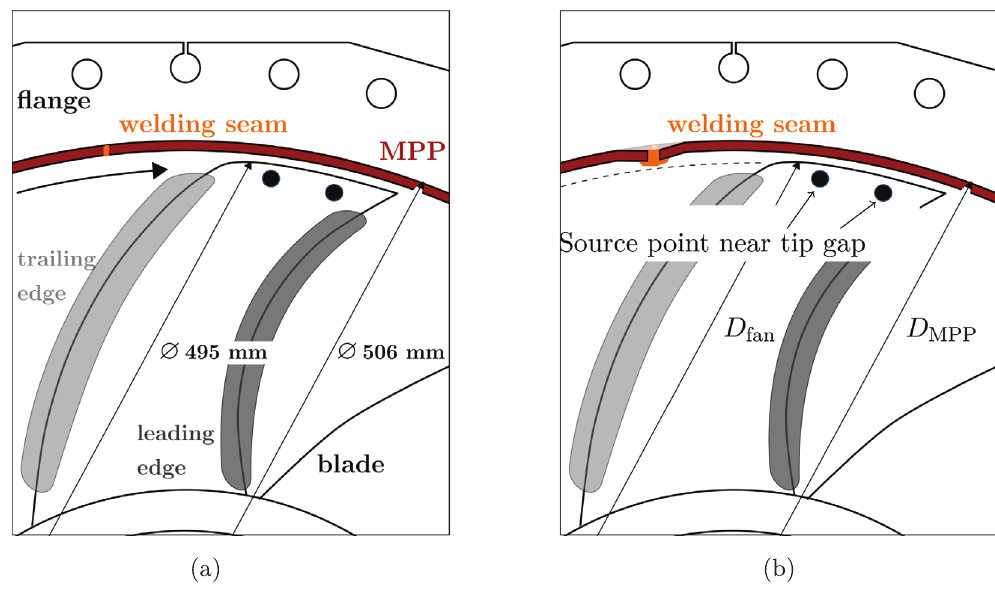
Figure 4. Dimensions and detail of the tip gap region of a fan with forward skewed blades (F); front view. (a) Ideal joint MPP sheet. (b) Constructed joint with a constricted tip gap; source points